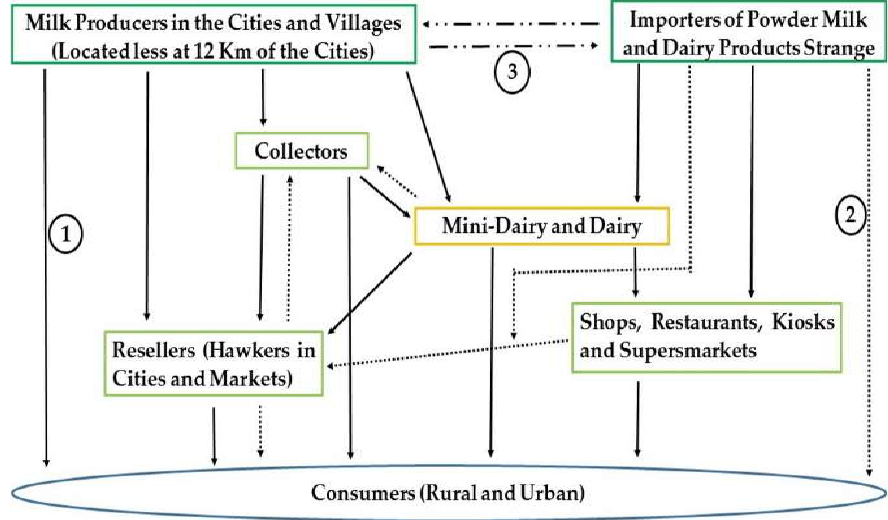
Figure 2. Milk and dairy products marketing circuit of the cities in Burkina Faso.